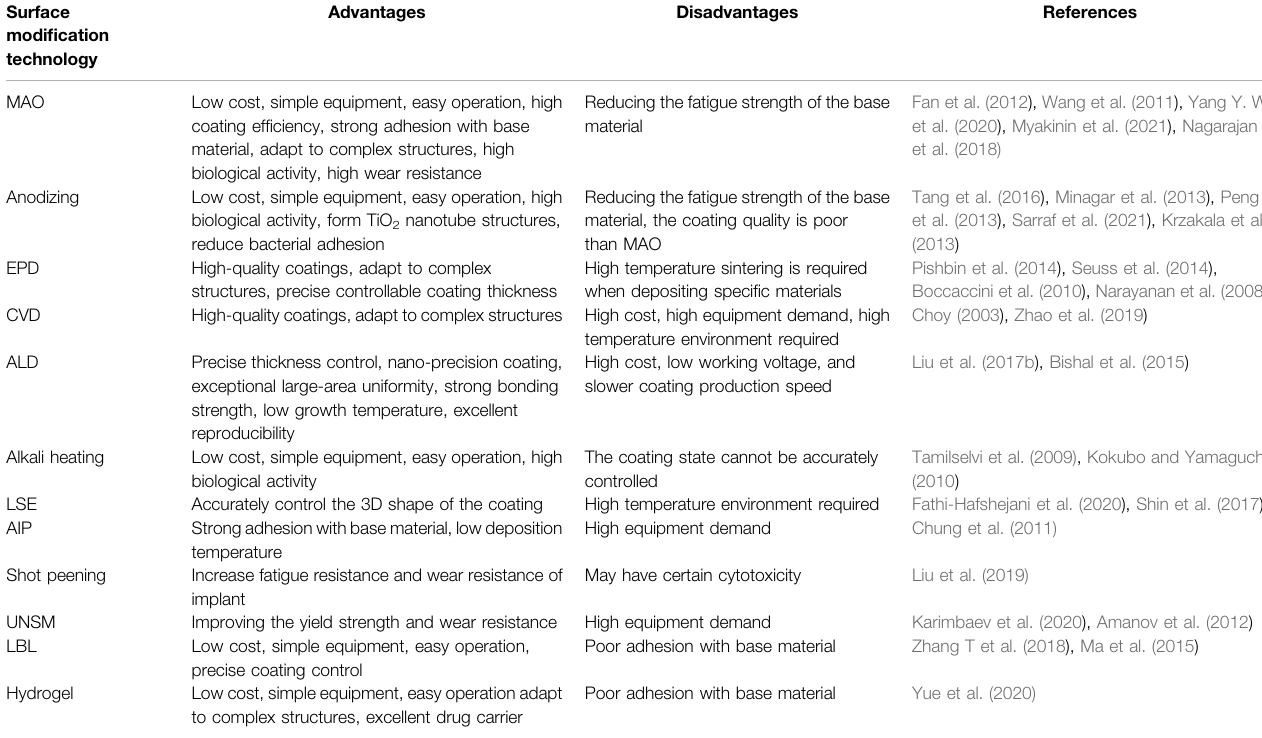
TABLE 2 | Summary of surface modi fi cation technology, advantages and